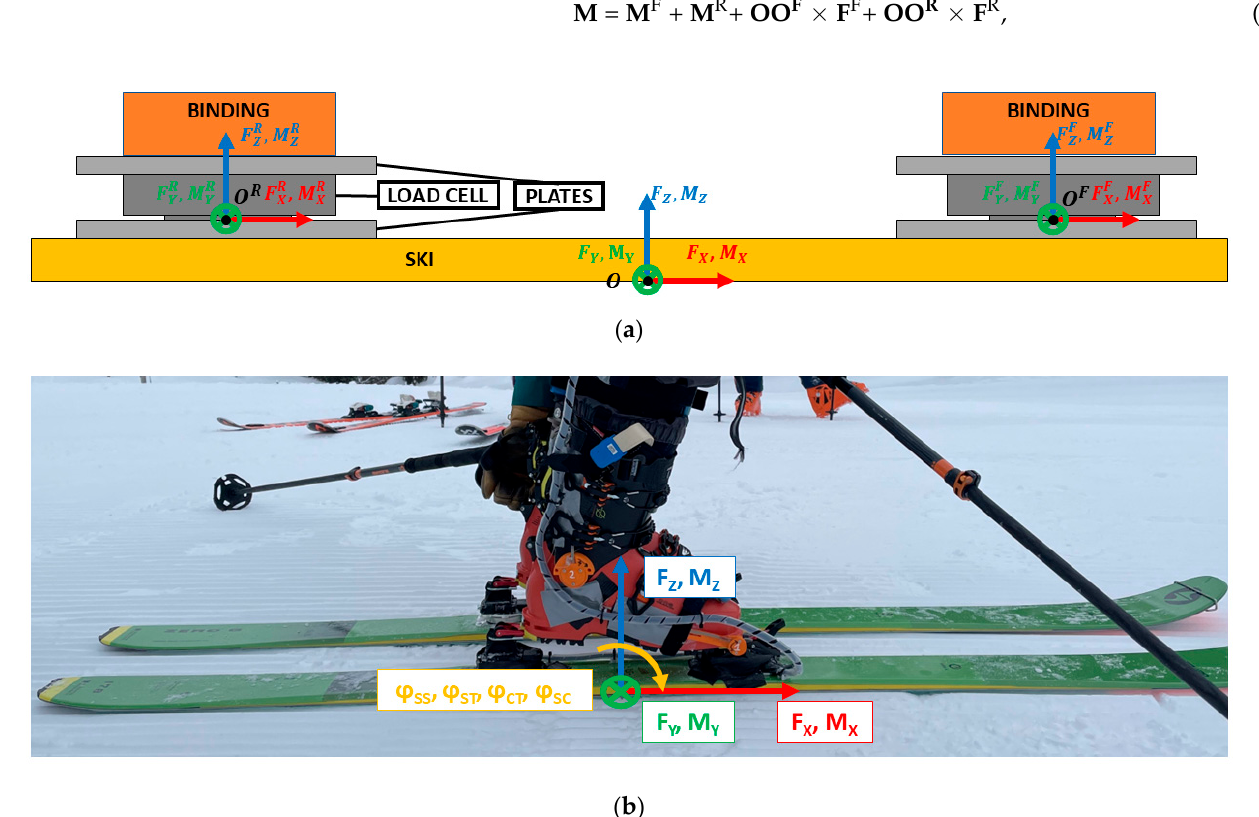
Figure 5. ( a ) Load cells position with respect to ski; ( b ) assembled system with GRF and kinematics reference systems and sign